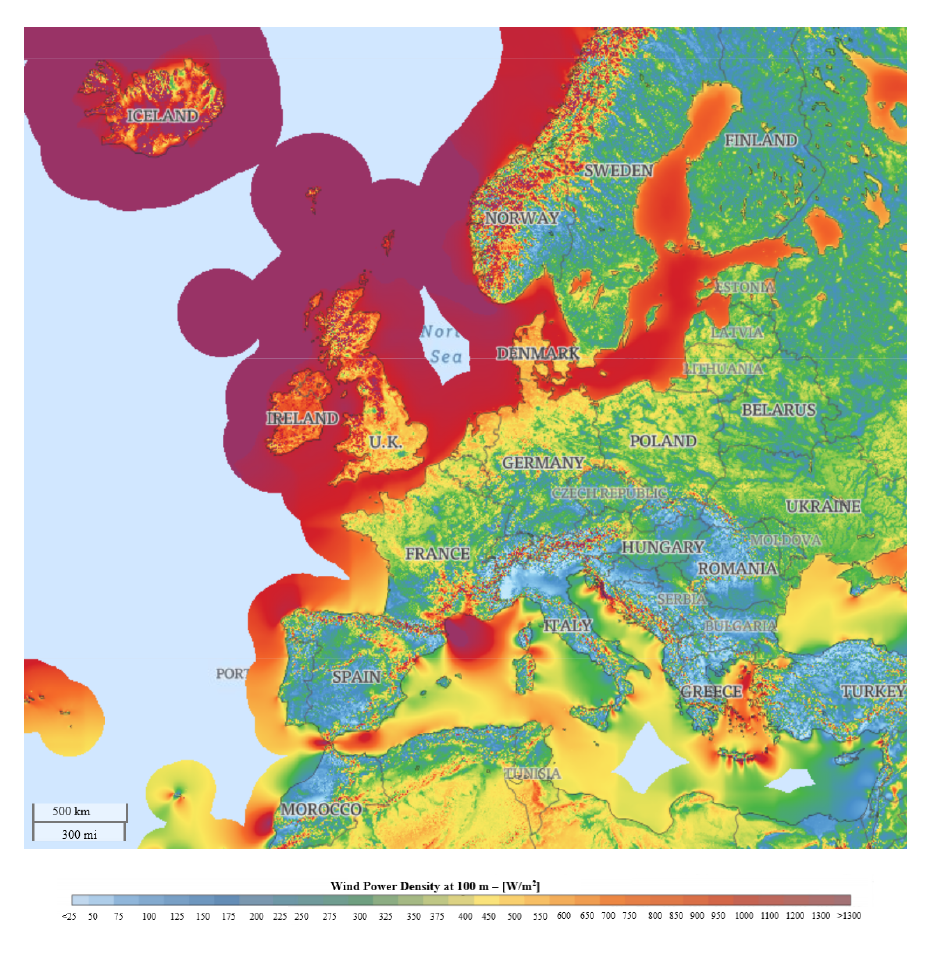
Figure 1. Wind Power Density at 100 m, adapted from